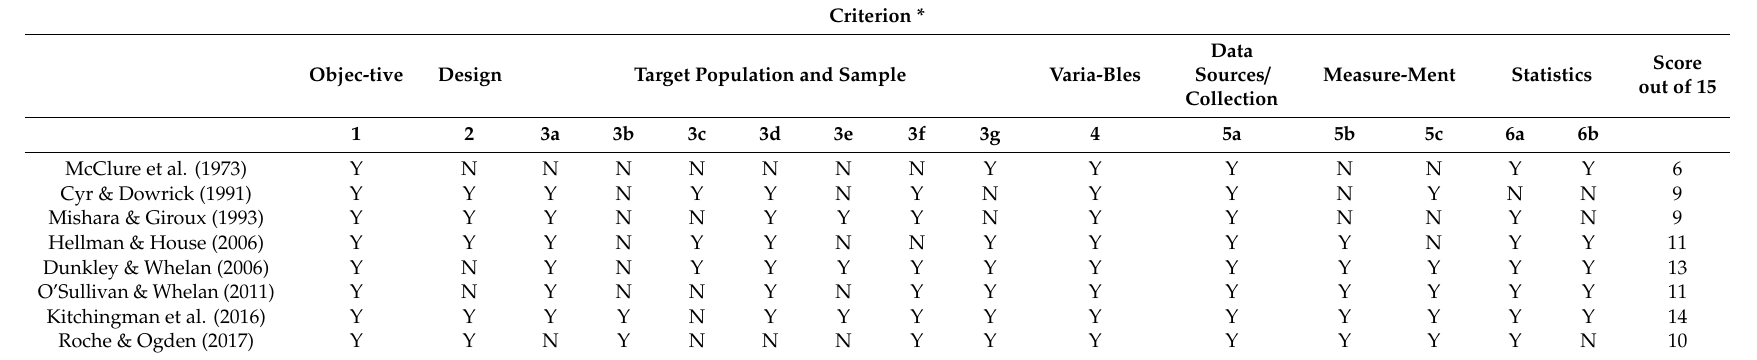
Table A1. Quality assessment for all included survey studies, in order of year of publication.